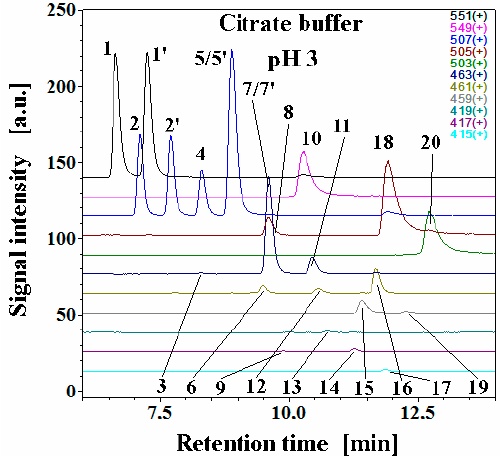
Figure 7. Chromatographic LC-MS profiles of selected ions of betanin as well as its decarboxylated and dehydrogenated derivatives generated in betalain-rich extract after 60-min heating experiments in citrate buffers at pH 3 and 85 °C.